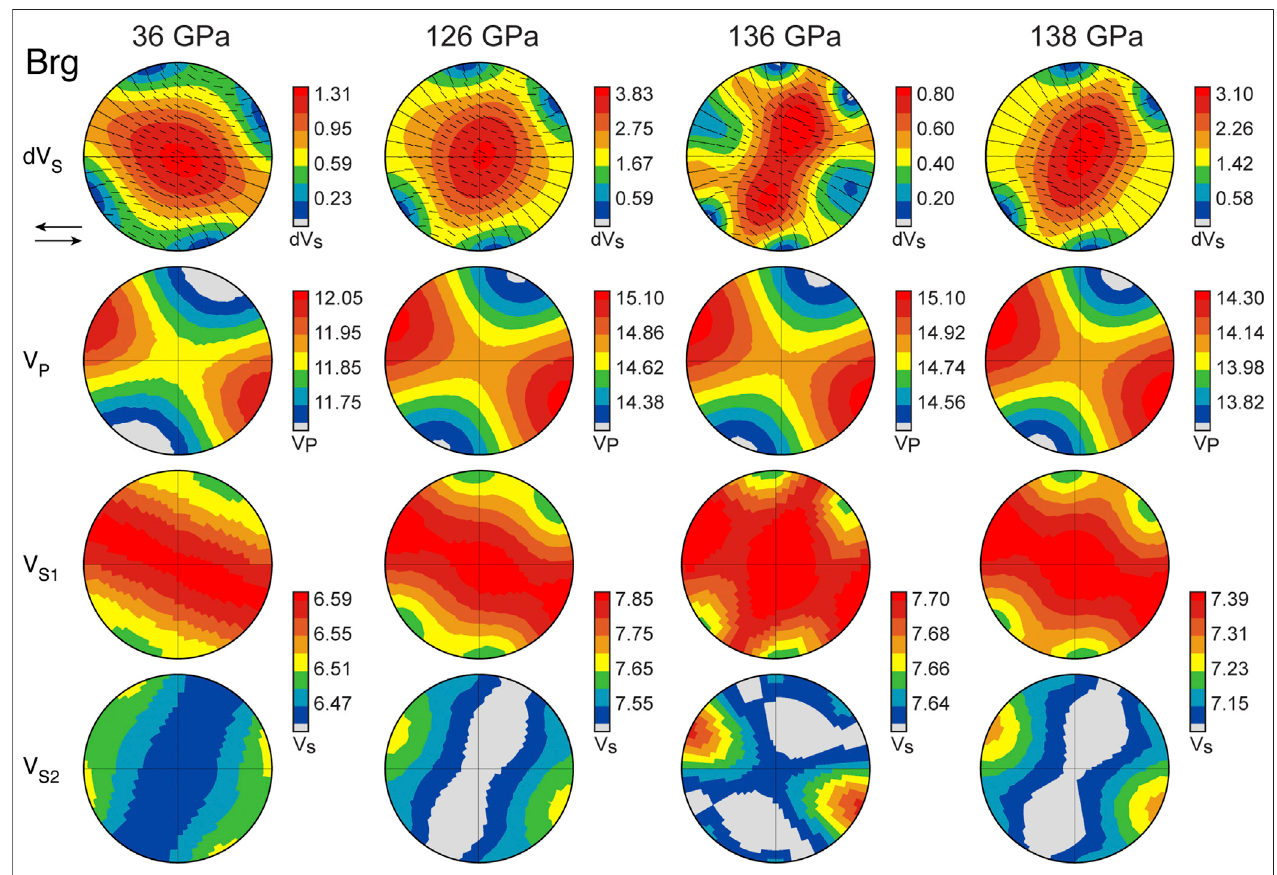
FIGURE9| Stereo-plots(producedbyBeartexsoftware)ofshearwavesplitting( δ V S inpercent),P-wavevelocity(V P inkm/s),thefastshearwave(V S1 inkm/s),and the slow shear wave (V S2 in km/s) for a bridgmanite aggregate at 100% strain. VPSC textures used tocreate the stereo-plots are from our results for the slip system pair (100)[010] + (100) 〈 011 〉 when extrapolated to pressure and temperature conditions of 36 GPa and 2,000 K, 126 GPa and 2,800 K, 136 GPa and 4,000 K, and 138 GPa and 3,500 K. Elastic constants used to create velocity surfaces are summarized in Supplementary Table S3 . Sense of shear is top left, shown by the arrows. Eigenvectors of the fast, polarized S-wave are shown as black dashes. Note that each hemispheric projection shows a different range of δ V S .